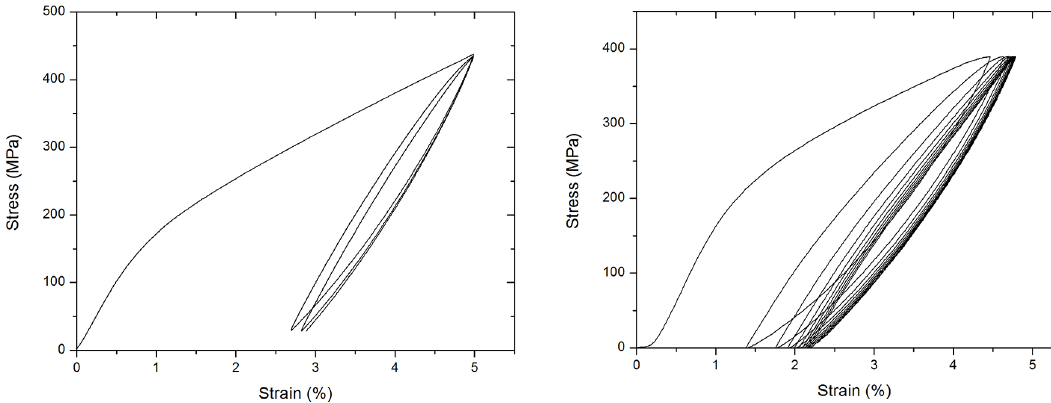
Figure 5. Test for quantification of superelasticity at 0 ºC with 3 cycles of strain for Cu-11.8Al-0.6Be-4Nb (wt.%) alloy. 40 cycles while the alloy with 4% Nb was submitted to 10 cycles, both tests were performed at 25 ºC.